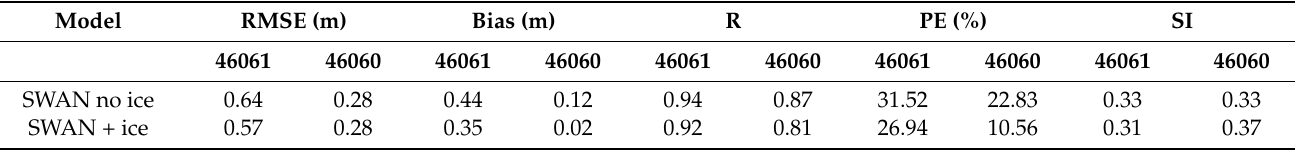
Figure 4. Significant wave height, H s , as measured by wave buoys and modeled by SWAN with and without ice in December of 2016–2019 (left axis). Sea ice concentration calculated from AMSR2 data at the location of buoy 46061 with the zero line marked as dashed (right axis). ( a , c ,e, g ) Comparisons at wave buoy 46061 near the mouth of PWS. ( b , d , f , h ) Comparisons at wave buoy 46060 inside of PWS where the waves are smaller. Data were missing from buoy 46061 for part of December 2018. Table 2. SWAN model performance with and without ice at buoys 46061 and 46060. Statistics were calculated from 28,191 comparisons over the years of 2016–2020, excluding July, August, and